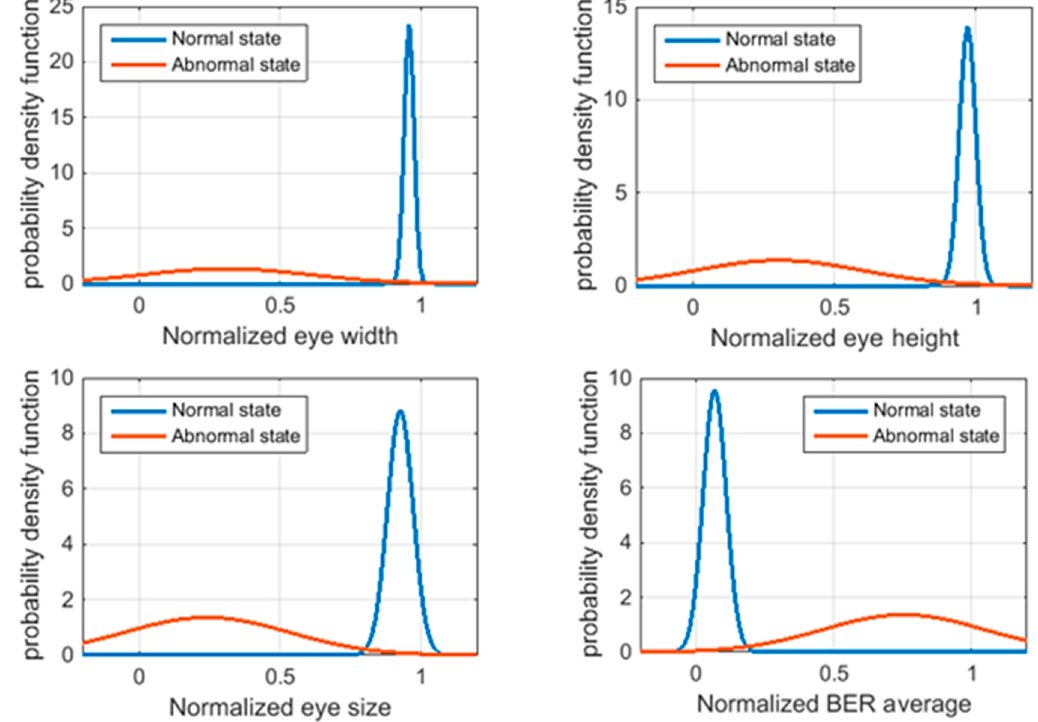
Figure 11. Probability density function of the features extracted from the BER matrix (Test #1).